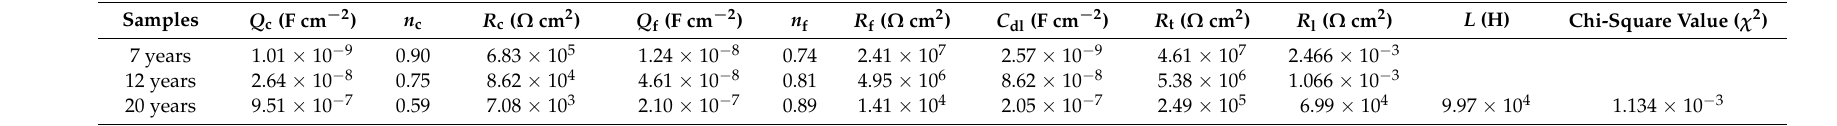
Table 4. Simulated parameters of EIS results of coated samples exposed for 7, 12, and 20